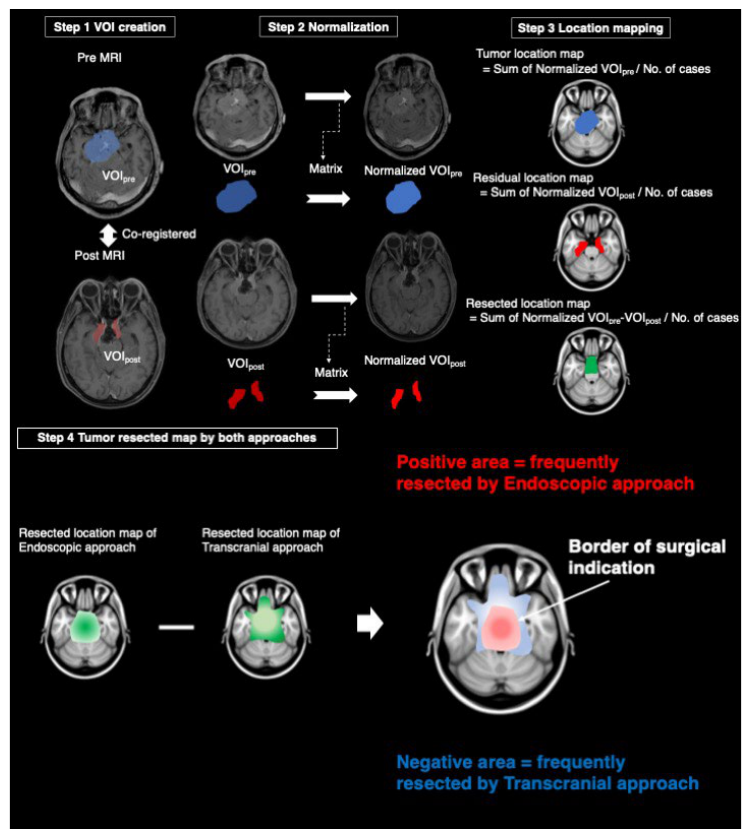
Figure 1. The workflow of voxel-based-lesion mapping. Step 1: The creation of the voxels-of-interest (VOIs) from pre-and post-MRI after co-registration. Step 2: Reslicing of VOIs using a matrix obtained from the transformation of pre-and post- magnetic resonance images into normal brain. Step 3: Tumor and residual location maps were created by the sum of normalized VOI pre and normalized VOI post divided by a number of cases, respectively. Resected location map was created by the subtraction of the residual location map from the tumor location map divided by a number of cases. Step 4: Tumor resected maps by both approaches were obtained by subtracting the resected location map of transcranial approach from that of endoscopic approach. VOI: the voxels-of-interest, MRI: magnetic resonance